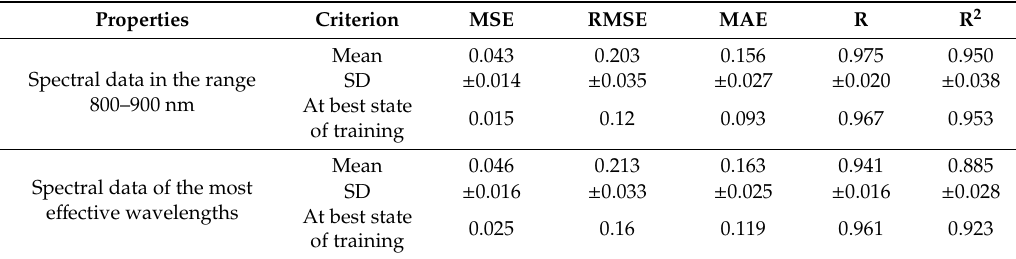
Table 3. Comparison of the mean and standard deviation of criteria of ANN-BBO for estimating starch content of Fuji apple in 100 replicates using spectral data of 800 to 900 nm and data on e ff ective wavelengths.